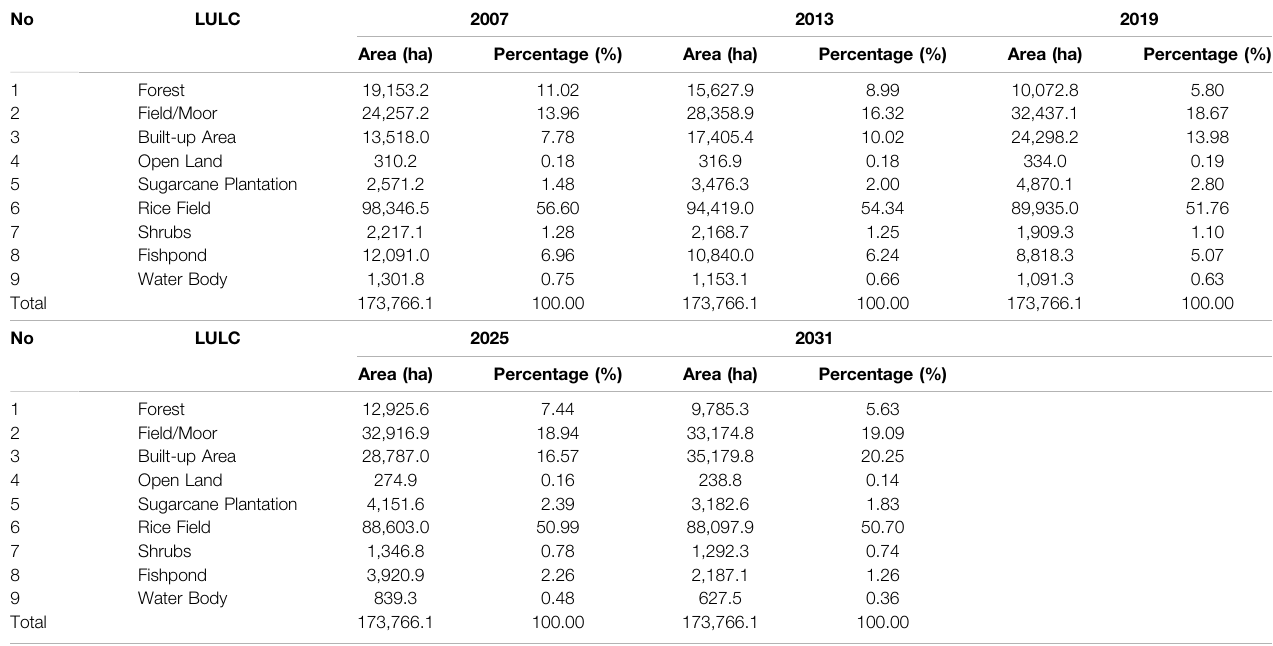
TABLE 1 | Area and percentage of each land-use/land-cover in 2019 – 2031 and their